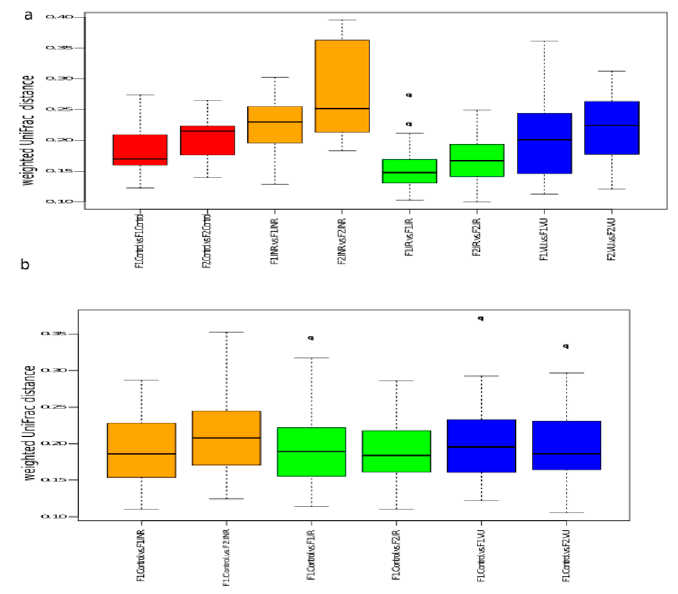
Figure 5. ( a ) Beta diversity at baseline (F1) and after prebiotics (F2) for control (red), INR (orange), IR (green), and VU (blue) groups. ( b ) Weighted UniFrac distances between Control.F1 and F1 or F2 of INR (orange), IR (green), and VU (blue). INR, immunological ART non-responders; IR, immunological ART responders; VU, viremic untreated.